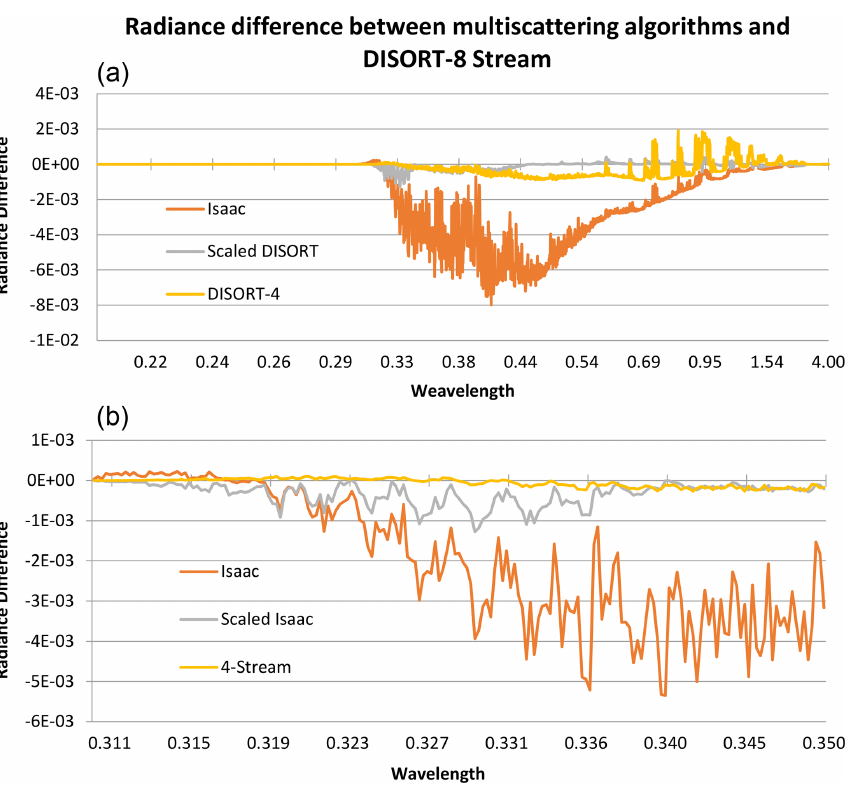
Figure 7. Radiance differences between various multi-scattering algorithms and DISORT eight-stream. (a) The whole simulated spectrum of 0.2–4µm. (b) Zoom on 0.3–0.35µm (relative azimuthal angle 1 . 9 ◦ , view angle 76 . 3 ◦ , and solar zenith angle 87 . 2 ◦